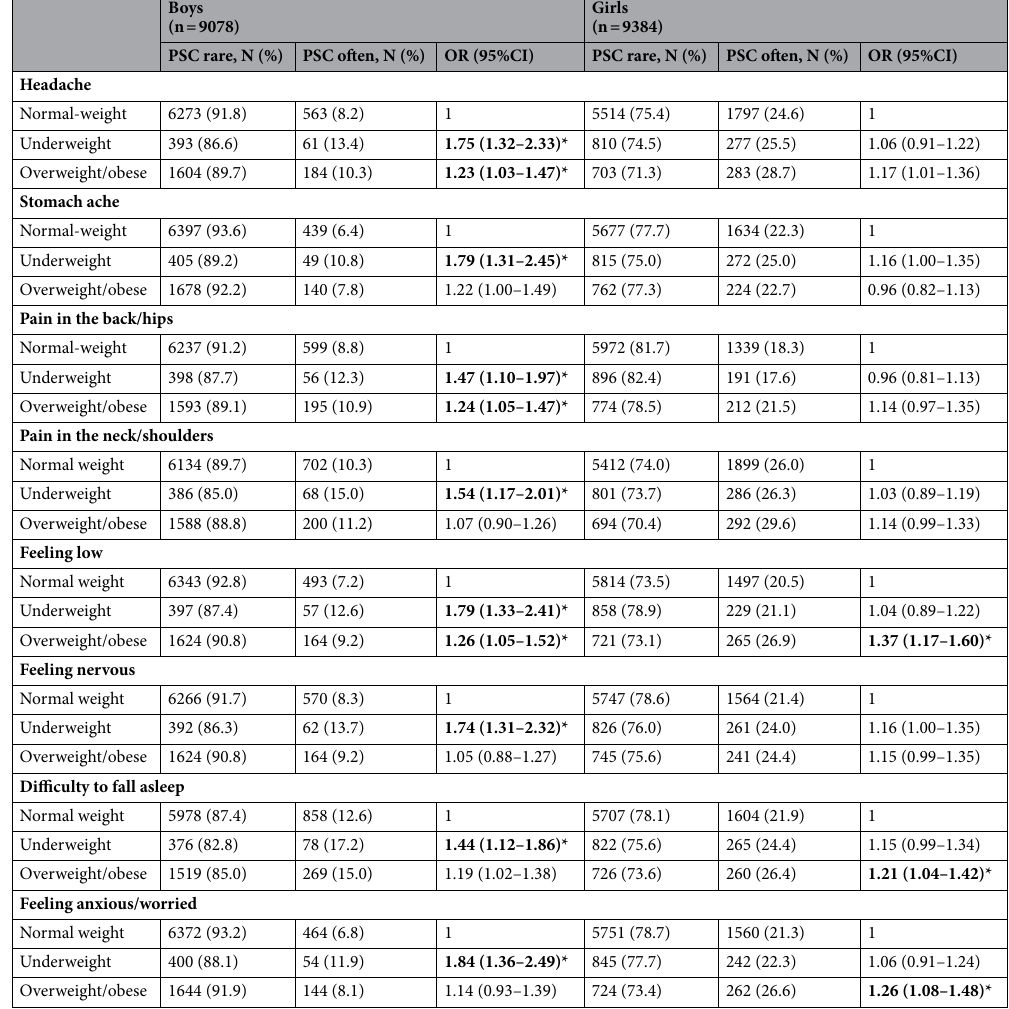
Table 3. Associations of weight status and self-reported psychosomatic complaints (PSC). Logistic regression models adjusted for adolescent’s age, parents’ ethnic background, family household structure, parents’ employment status, school location, and year of survey. PSC rare answer alternatives: never, seldom, sometimes; PSC often answer alternatives: often, always. CI confidence interval; PSC psychosomatic complaints. *Associations passed a critical P value corresponding to FDR of